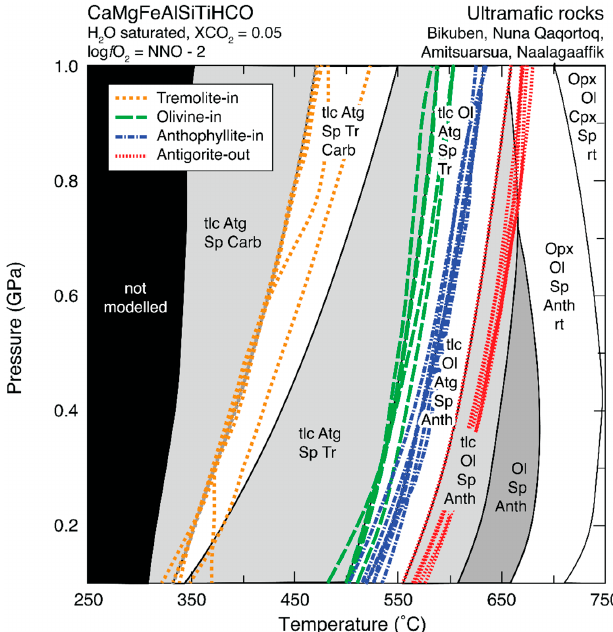
Figure 7. Typical pseudosection for an ultrama fi c rock with the locations for the tremolite-in, olivine- in, anthophyllite-in and antigorite-out reactions shown for the full range of ultrama fi c rock compositions throughout the Tartoq belt. Minerals starting with a capital letter were modelled as a solid solution. Atg = antigorite; tlc = talc; sp = spinel; carb = carbonate; tr = tremolite; ol = olivine; anth = anthophyllite; opx = orthopyroxene; rt = rutile; cpx = clinopyroxene.